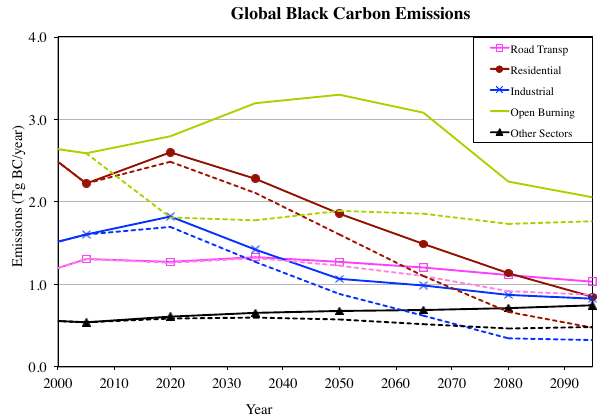
Fig. 2. Global black carbon emissions by sector under a reference case (solid lines) and RCP4.5 policy scenario (dotted